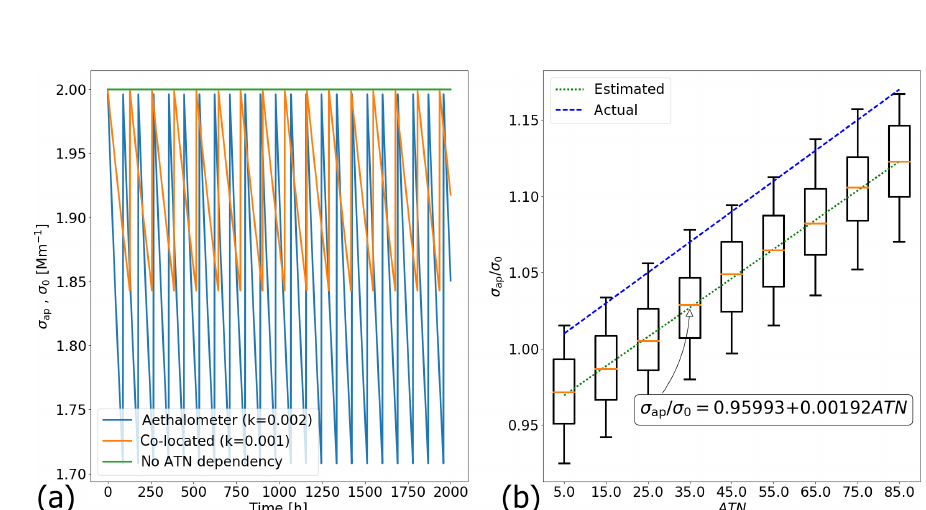
Figure B1. (a) shows the time series of an ATN-dependent σ 0 for a hypothetical Aethalometer and co-located PSAP so that the filter changes were not performed in synchronisation. The “No ATN dependency” in the figure legend denotes σ ap in Eq. (B1), from which both the hypothetical instrument ATN dependencies were calculated. (b) shows the ATN dependence of the Aethalometer when compared to the ATN-dependent co-located